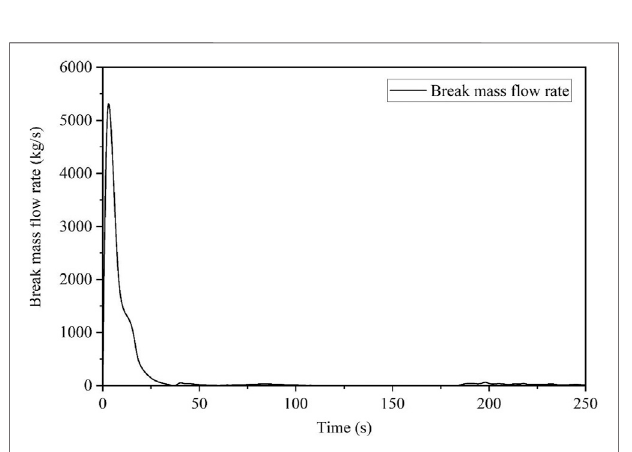
FIGURE 6 | Double-ended CL LBLOCA break mass fl ow rate. FIGURE 7 | Double-ended CL LBLOCA CMT injection mass fl ow